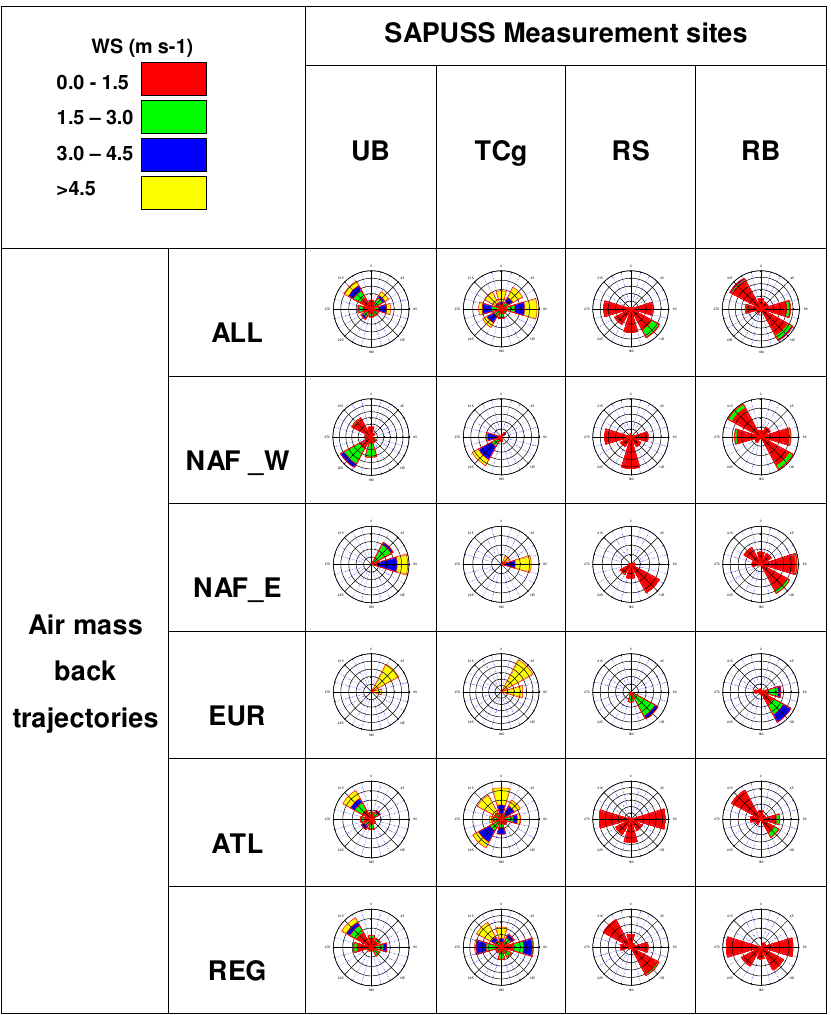
Fig. 5. Wind roses at four different SAPUSS monitoring sites for all study (ALL) and for selected air mass types.